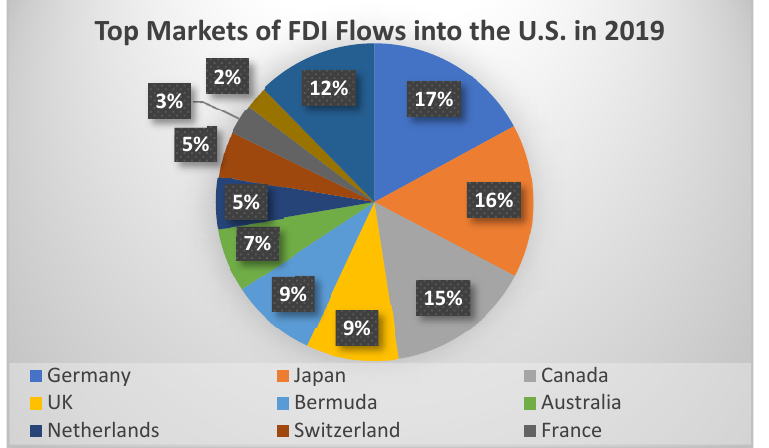
Figure 2. Top Markets of FDI Flows into the U.S. in 2019 (Data source: SelectUSA, Sources of FDI into the United States).